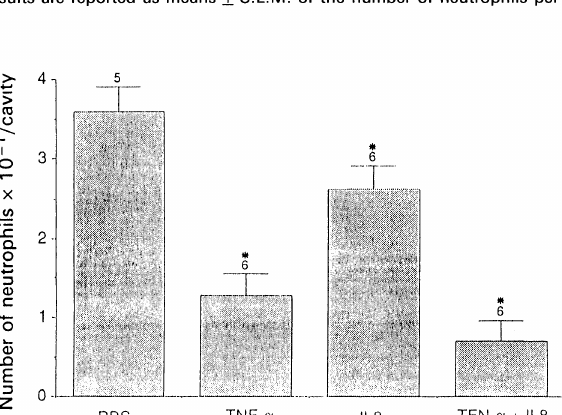
FIG. 4. Effect of intravenous pretreatment of rats with either mrTNF-, hrlL-8 or both, upon carrageenan induced neutrophil migration into peritoneal cavities. The dose of each cytokine was 2 lag/animal. Results are means _+ S.E.M. of the number of animals given above each bar. (*p < 0.01, Student’s